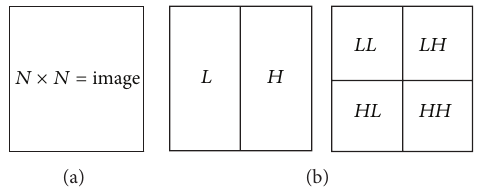
Figure 1: (a) Input image with size 𝑁 × 𝑁 . (b) First level decomposition of the input